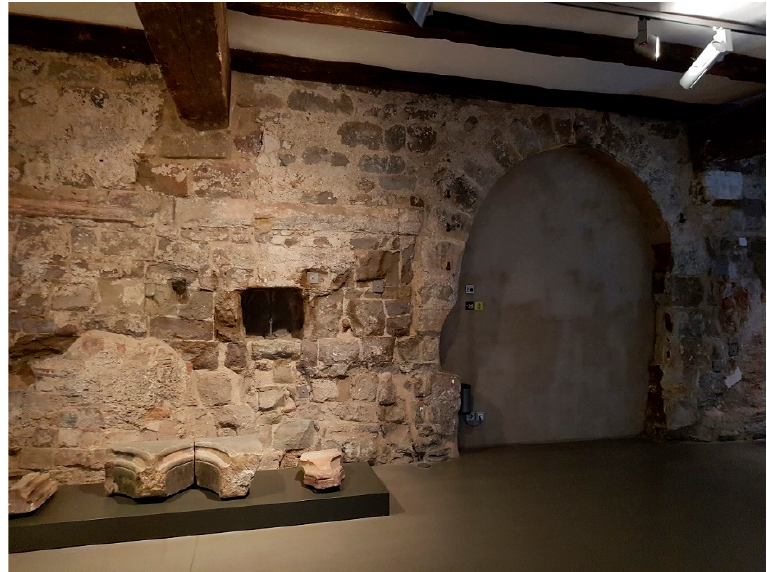
Figure 2. Gateway in the Eastern Wall (Maria Stürzebecher).